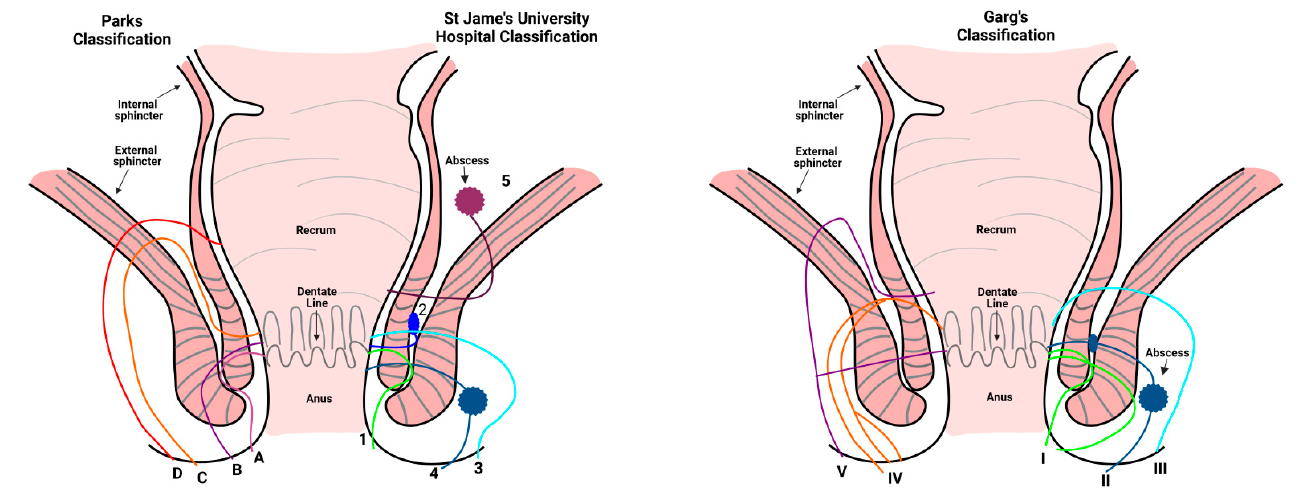
Figure 1. The classification of perianal fistulas. Parks classification: A. intersphincteric fistulas; B. transsphincteric fistulas; C. suprasphincteric fistulas; D. extrasphincteric fistulas. St James’s University Hospital classification: Grade 1. simple linear intersphincteric fistulas; Grade 2. intersphincteric fistulas with abscesses; Grade 3. transsphincteric fistulas; Grade 4. transsphincteric fistulas with abscesses; Grade 5. supralevator and translevator fistulas. Garg’s classification: I. low liner intersphincteric and transsphincteric fistulas; II. low intersphincteric and transsphincteric fistulas; III. high liner transsphincteric fistulas; IV. complex high transsphincteric fistulas; V. suprasphincteric infralevator fistulas. 3. Epidemiology The reported incidence of perianal fistulas varies substantially. Zanotti and colleagues searched the European hospital databases in four different countries and concluded that the incidence of perianal fistulas ranges from 1.2 to 2.8/10,000/year in Europe. However, they did not differentiate between cryptoglandular and CD-associated perianal fistulas [22]. A systematic literature review indicated that the most predominant perianal fistulas are cryptoglandular and CD-associated fistulas, whose estimated incidence in Europe is 0.86 and 0.21/10,000/year, respectively [23]. In the United States, the annual incidence was 20,000 to 25,000 cases [24]. In China, perianal fistulas make up 1.67 to 3.60% of anorectal diseases [25]. However, due to the limited reports in different areas, it is difficult to ascertain that the incidence of perianal fistulas differs from geographical region. Additional data from a study in England reported that the overall rate of fistula formation following anorectal abscess was 17.2% (27,349/158,713) within a 15-year (from 1997 to 2012) follow-up period [26]. Sub-classification on the cause of fistula formation following an anal abscess revealed that the rate of cryptoglandular fistulas was 15.5% and the rate of CD-associated fistulas was 47.2%. This suggests that CD is a risk factor for the development of fistulas in patients with an abscess. For CD, it is reported that 13.9% to 28.8% of patients suffer from the perianal fistulizing disease [27,28]. Moreover, in patients with inflammation of the rectum, this number increases to 92% [29]. In the Netherlands, the data of the inflammatory bowel disease (IBD) South-Limburg (IBDSL) cohort showed that 13.9% (161/1162) of the CD patients developed a perianal fistula during the course of their disease, while the cumulative 5-year perianal fistula rate varied between 10.3% and 14.1% (from 1991 to 2011). The overall cumulative probability of developing a perianal fistula increases from 8.3% after 1 year to 11.6% after 5 years and 15.8% after 10 years [5], indicating that the risk of developing fistulas increases with a prolonged disease duration. In the Hong Kong territory-wide IBD registry, it was found that among 981 CD patients, 283 (28.8%) had